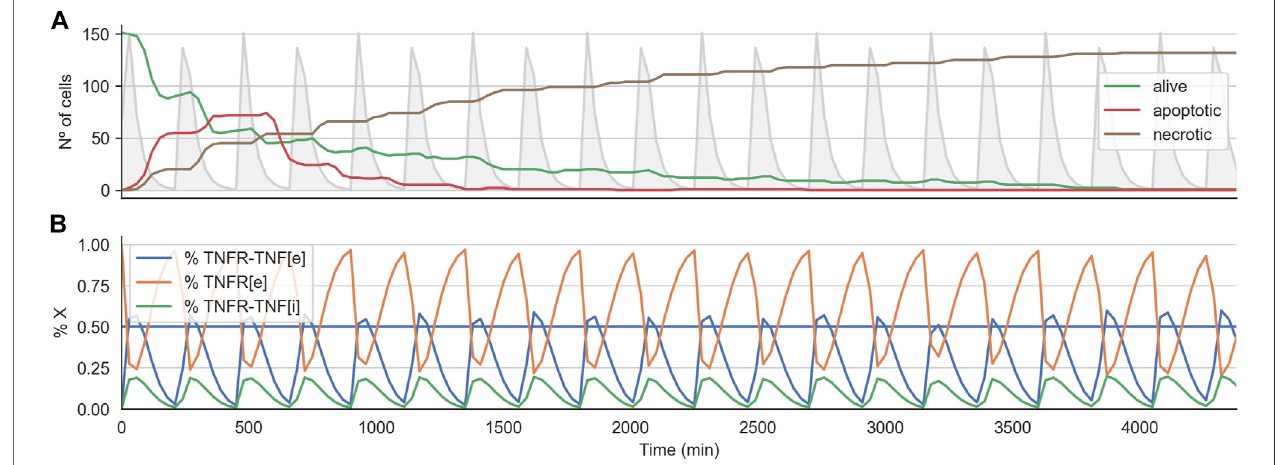
FIGURE 5 | Time course for effective treatment in 2D cell arrangement. Panel (A) shows the time course for the number ofalive, apoptotic, and necrotic cells. The lightgreycurveshowstheTNFpulses. Panel(B) showstheaveragestateoftheTNFRreceptormodelacrossallthealivecells.Thehorizontallineindicatesthethreshold at which the signal induced by the binding of the TNF propagates downstream to the Boolean